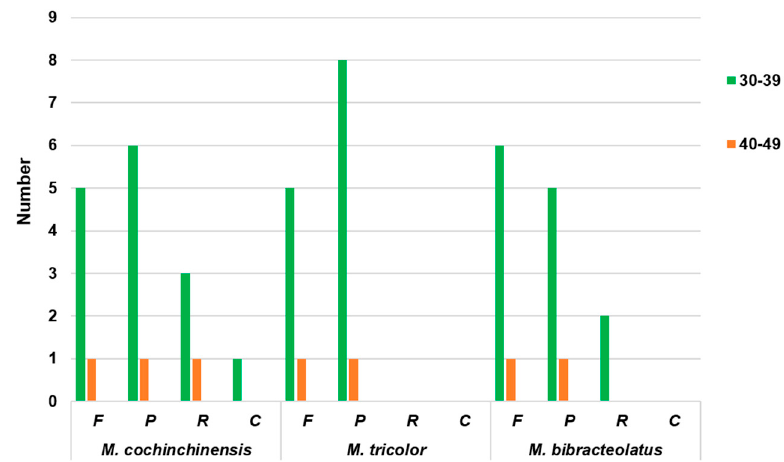
Figure 5. Repeat sequences in the chloroplast genomes of three Macrosolen species. F, P, R, and C indicate the repeat types F (forward), P (palindrome), R (reverse) and C (complement), respectively. Repeats with different lengths are indicated in different colors.